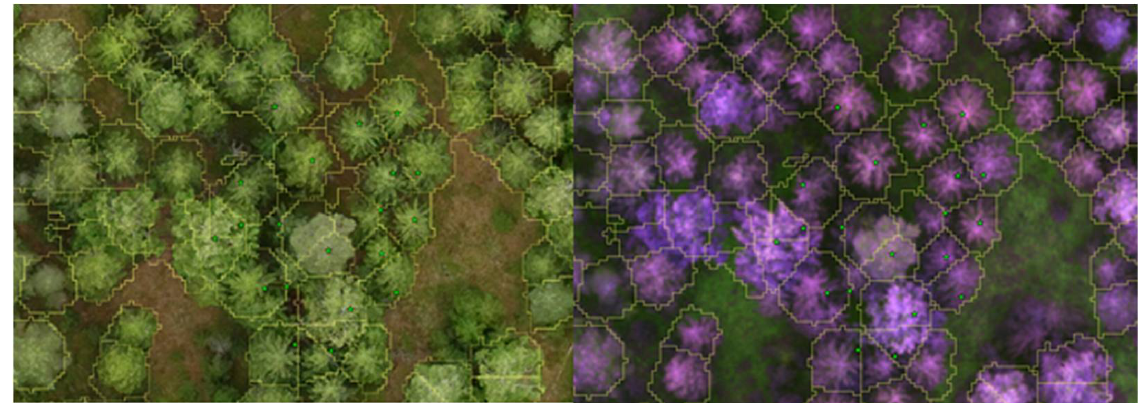
Figure 3. An example of the identified tree-crown segments with the field-measured trees (green star cross) on RGB (left) and multispectral (right) orthomosaics.